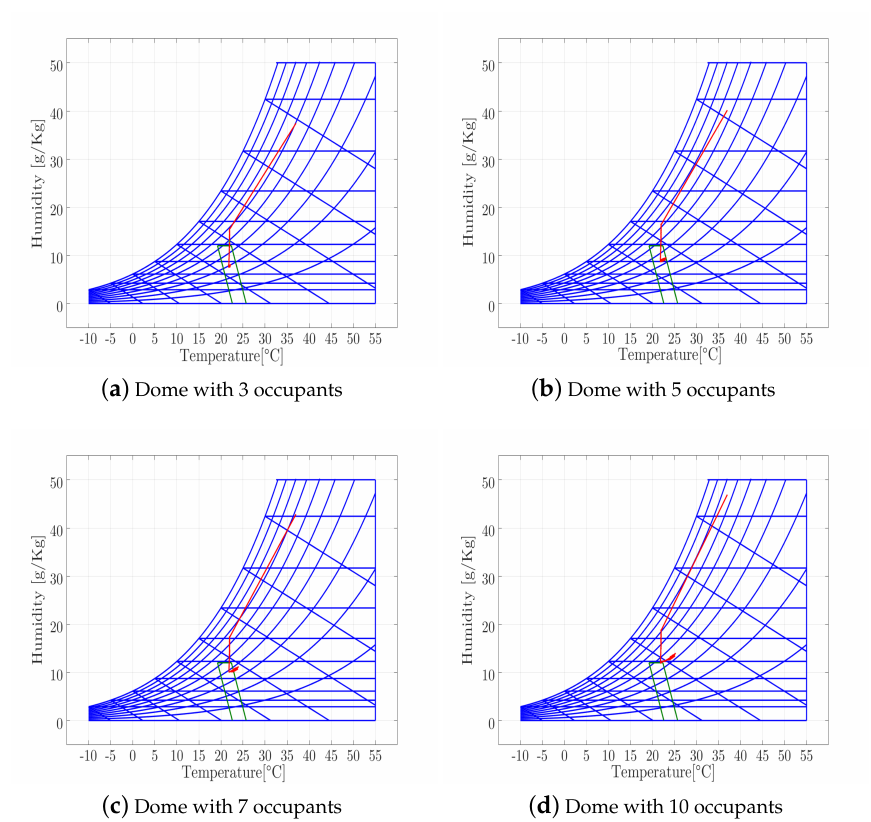
Figure 10. Psychrometric chart of a geodesic dome with different